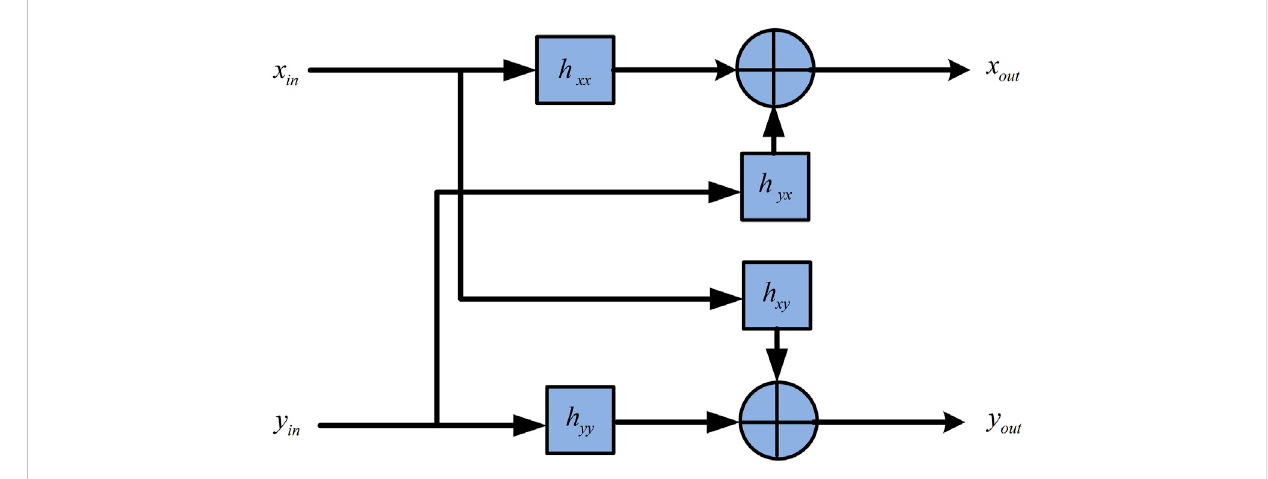
FIGURE 10 Complex fi